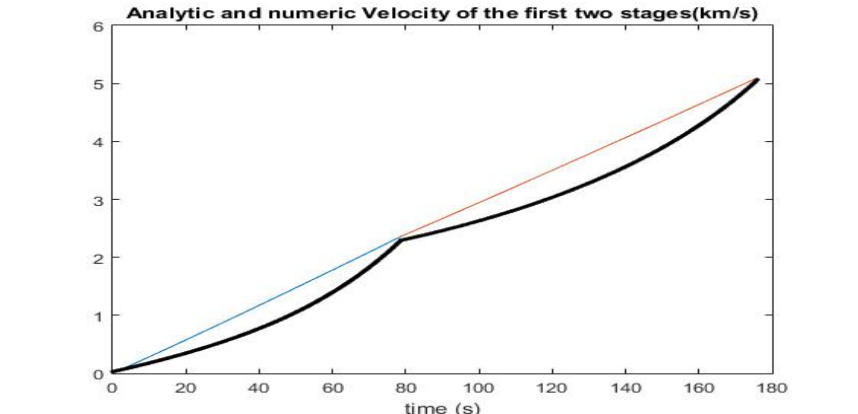
Figure 6. The velocity plot: analytic and numeric results during the gravity-turn arc. Numerical velocity of the first and second stage is in black, analytic velocity of the first stage is in blue and second stage in orange line.